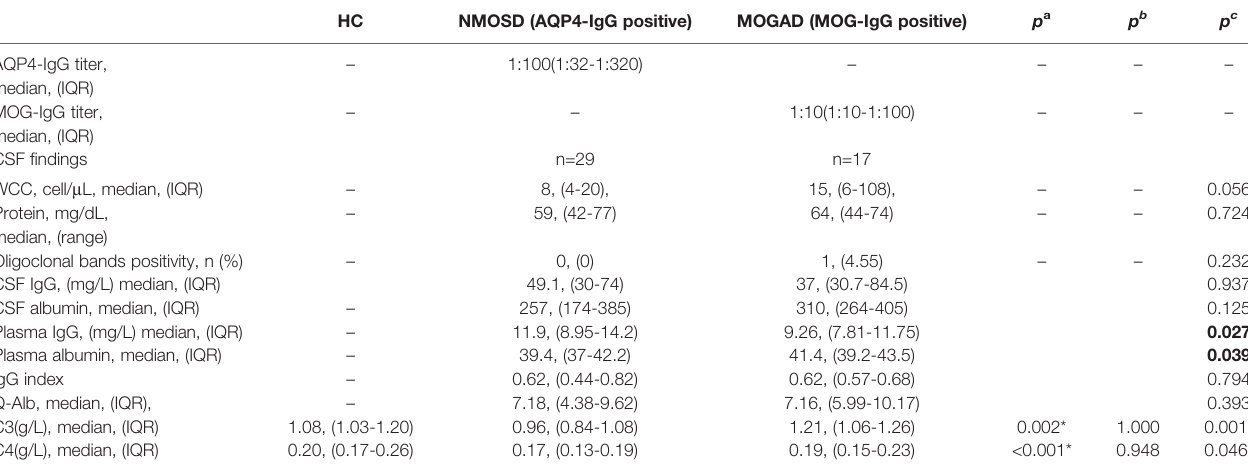
TABLE 2 | Plasma and CSF detailed fi ndings among patients with NMOSD and MOGAD patients.